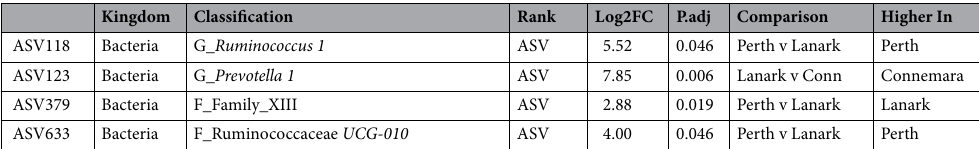
as differentially abundant. Two ASVs, ASV23 (Wald, P.adj < 0.01; Log2FC = 5.94) and ASV43 (Wald, P.adj < 0.05; Log2FC = 2.51) classified to the family Muribaculaceae were higher in Cheviot compared to Perth, ASV44 clas- sified to the genus Acetitomaculum was higher in Cheviot (Wald, P.adj < 0.05; Log2FC = 10.26) compared to Connemara, ASV55 classified as Sharpea azabuensis was higher in Perth (Wald, P.adj < 0.01; Log2FC = 4.81) compared to Cheviot, and ASV20 classified to Lachnospiraceae NK3A20 group was higher in the Lanark (Wald, P.adj < 0.05; Log2FC = 3.06) compared to Connemara. At the genus level Sharpea (Wald, P.adj < 0.001; Log2FC = 5.05) was higher in the Perth compared to the Cheviot, ASV223 classified to order Rhodospirillales (Wald, P.adj < 0.01; Log2FC = 7.03) was higher in the Cheviot compared to the Perth, and ASV461 classified to Clostridiales_vadinBB60 group was higher in the Lanark (Wald, P.adj < 0.05; Log2FC = 5.86) compared to the Connemara. At the family level Muribaculaceae (Wald, P.adj < 0.05; Log2FC = 2.23) was higher in Cheviot com- pared to Perth, ASV223 classified to order Rhodospirillales was higher in the Cheviot compared to the Conne- mara (Wald, P.adj < 0.05; Log2FC = 7.11) and Perth (Wald, P.adj < 0.01; Log2FC = 6.81), ASV461 classified to